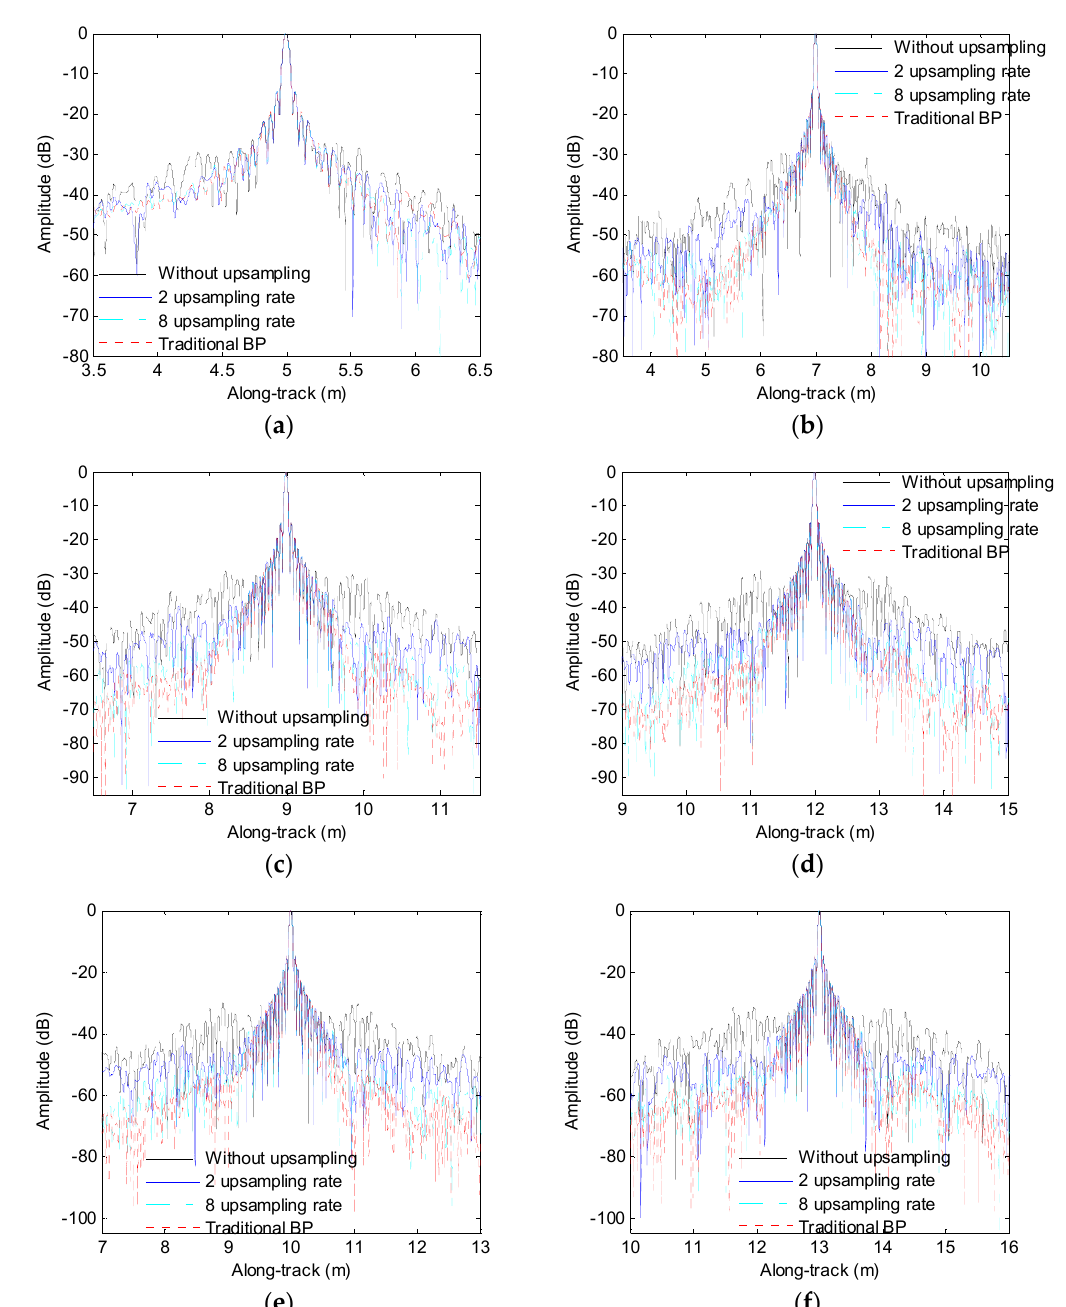
Figure 9. Along − track slices of focused targets. ( a ) T1; ( b ) T2; ( c ) T3; ( d ) T4; ( e ) T5; ( f ) T6.